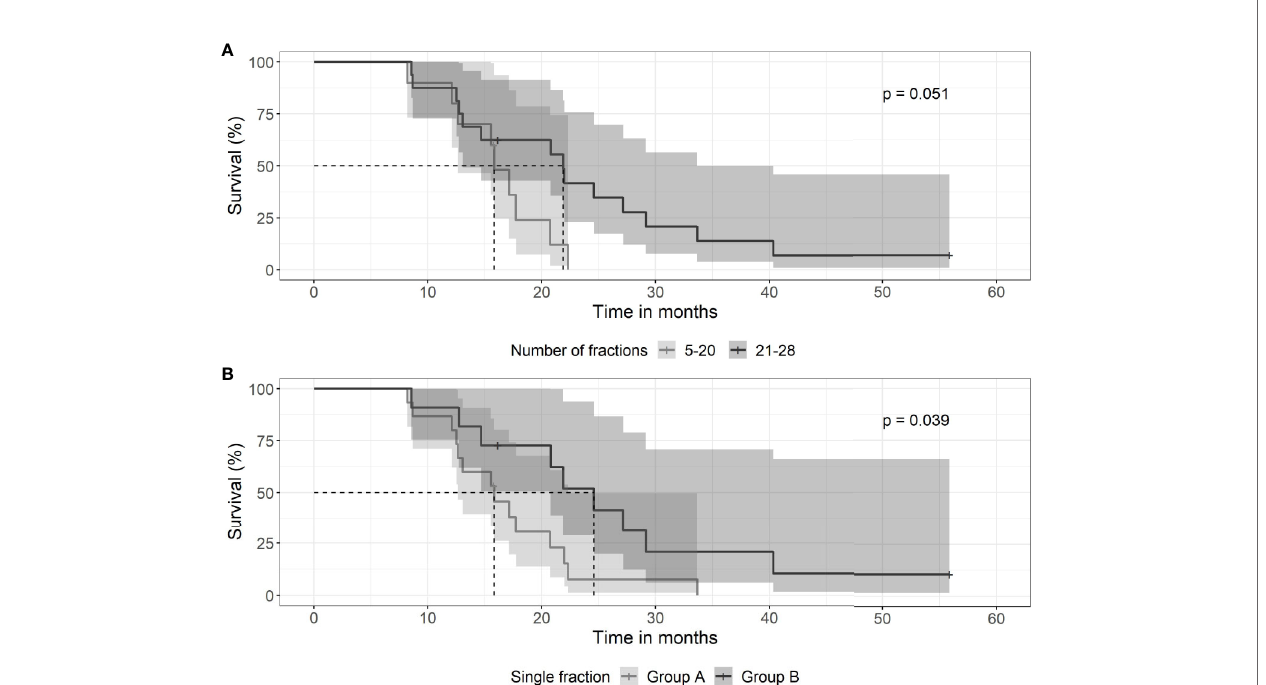
FIGURE 4 | Kaplan-Meier curves for survival between groups of patients with differing fractionation schedule. (A) SRT and number of daily fractions. Patients treated with 5 – 20 fractions (gray line) had a median survival time of 15.8 months (0.95 LCL – 0.95 UCL: 12.7 – NA months), compared to patients treated with 21 – 28 fractions (black line) with a median survival time of 21.9 months (0.95 LCL – 0.95 UCL: 13.1 – 33.7 months). (B) Patients treated with low daily doses of 1,6 to 1,65 Gy to a total dose exceeding 40 Gy (black line) had a median survival time of 24.6 months (0.95 LCL – 0.95 UCL: 20.8 – NA months), compared to those patients treated to a dose of <40 Gy (gray line) with a median survival time of 15.8 months (0.95 LCL – 0.95 UCL: 12.7 – 22.3 association of Ki-67 expression with treatment length shown in Figure 4 .